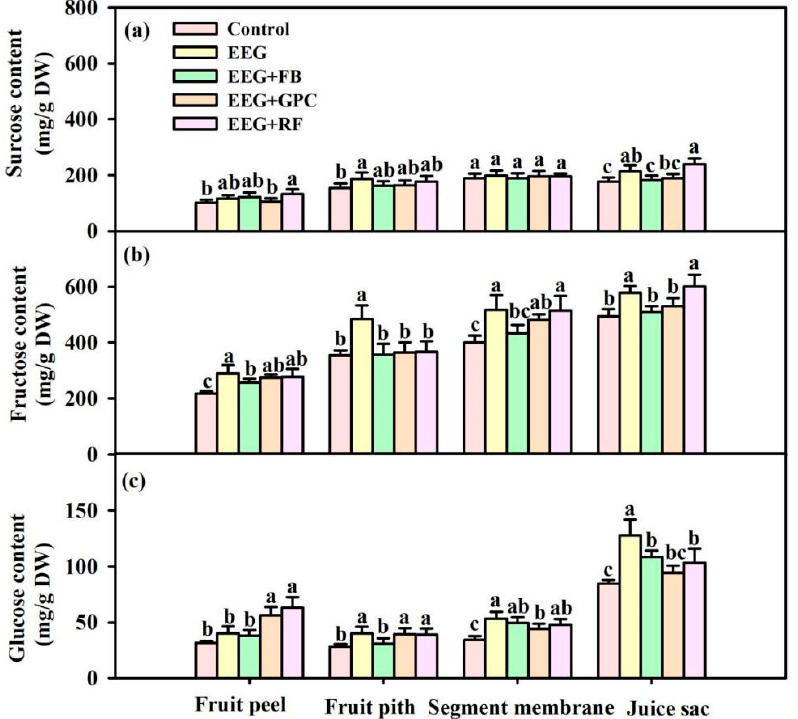
Figure 3. Effects of foliar spraying easily extractable glomalin-related soil protein in combination with agronomic strategies on sucrose ( a ), fructose ( b ), and glucose concentrations ( c ) of fruits in Satsuma mandarin “Oita 4”. Data (means ± SD, n = 4) are significantly ( p < 0.05) different if followed by different letters above the bars. The abbreviations are shown in Figure 1 .